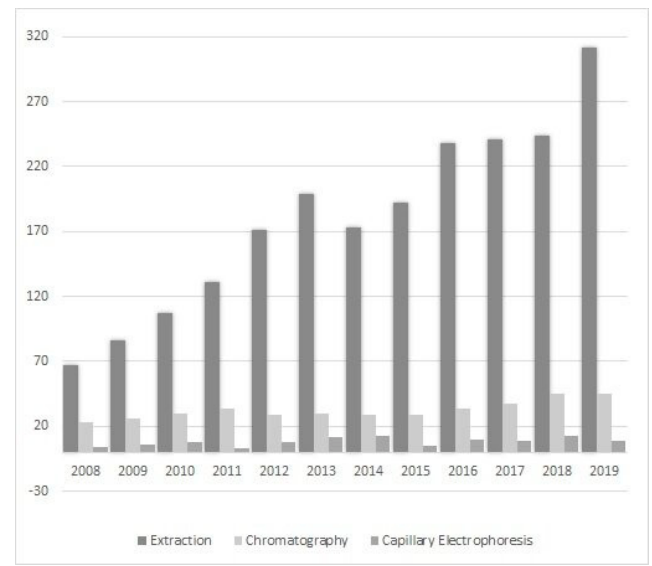
Figure 1. Number of publications on the use of ILs in sample preparation (extraction and microextraction) and chromatographic and electrophoretic techniques in 2008–2019 (the authors own elaboration according to ScienceDirect data).